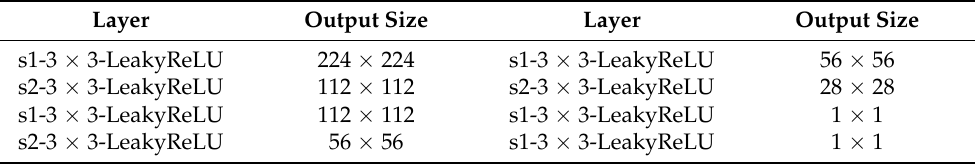
Table 2. Discriminant network